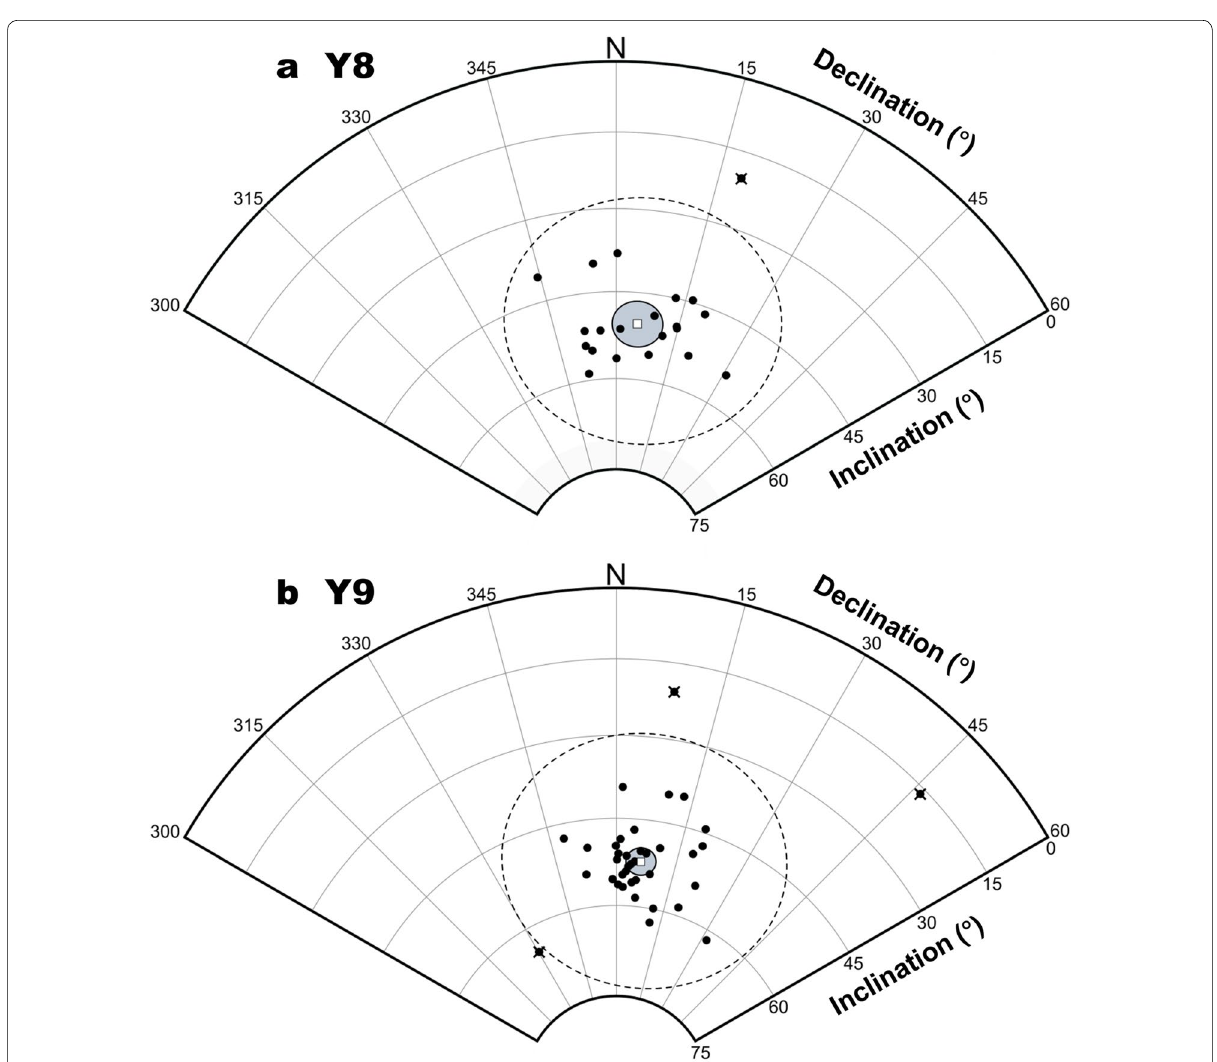
Fig. 4 Equal area projection of the paleodirection results for Y8 ( a ) and Y9 lava ( b ). Solid and open circles, respectively, represent projections onto the lower and upper hemisphere. The dashed circle is the rejection circle of McFadden (1982). Rejected results are denoted by crosses. Squares represent the mean direction with a 95% confidence circle, which is filled in as gray, after application of criteria by McFadden